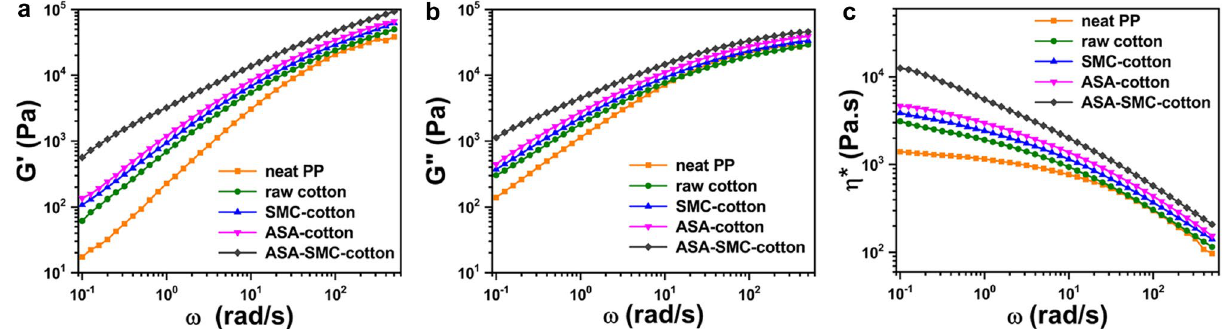
Figure 4. Plots of ( a ) storage modulus, ( b ) loss modulus, and ( c ) complex viscosity versus angular frequency for PP composites reinforced with 10% white raw cotton, SMC-cotton, ASA-cotton, and ASA-SMC-cotton.